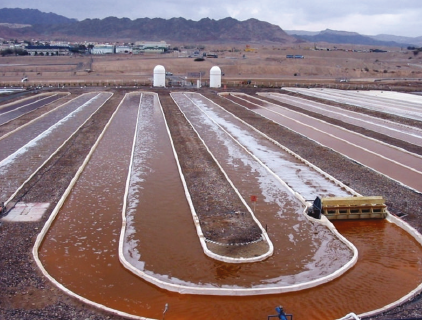
Figure 1: High rate algal ponds in Arizona, US (Renewable Fuel and Energy B.V.) [62].